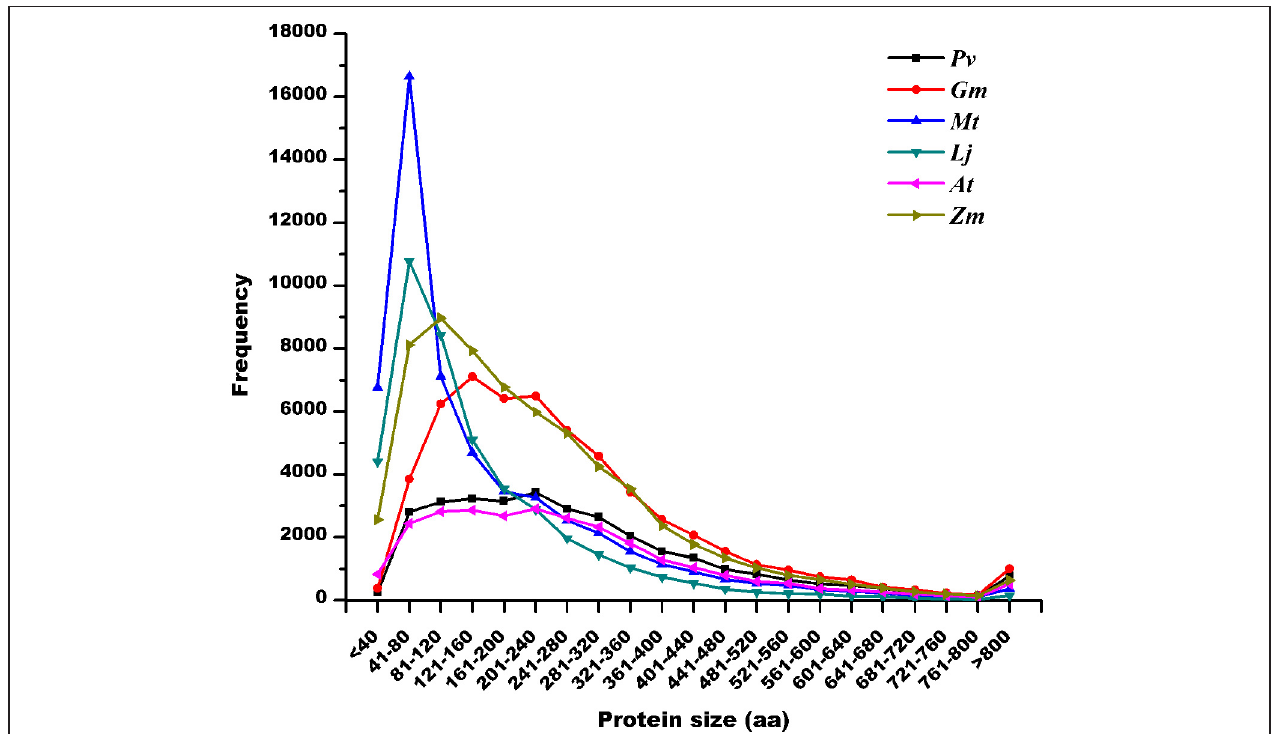
sizes in Mt3.0 annotation; Lj, L. japonicus protein sizes in Lj1.0 annotation; At, Arabidopsis thaliana protein sizes in